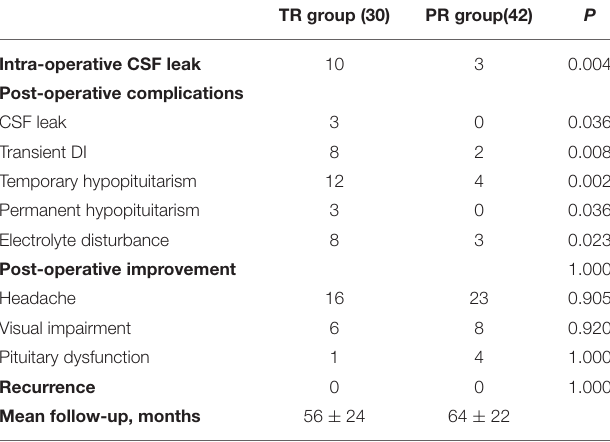
TABLE 3 | Intra- and post-operative complications and follow-up outcomes.